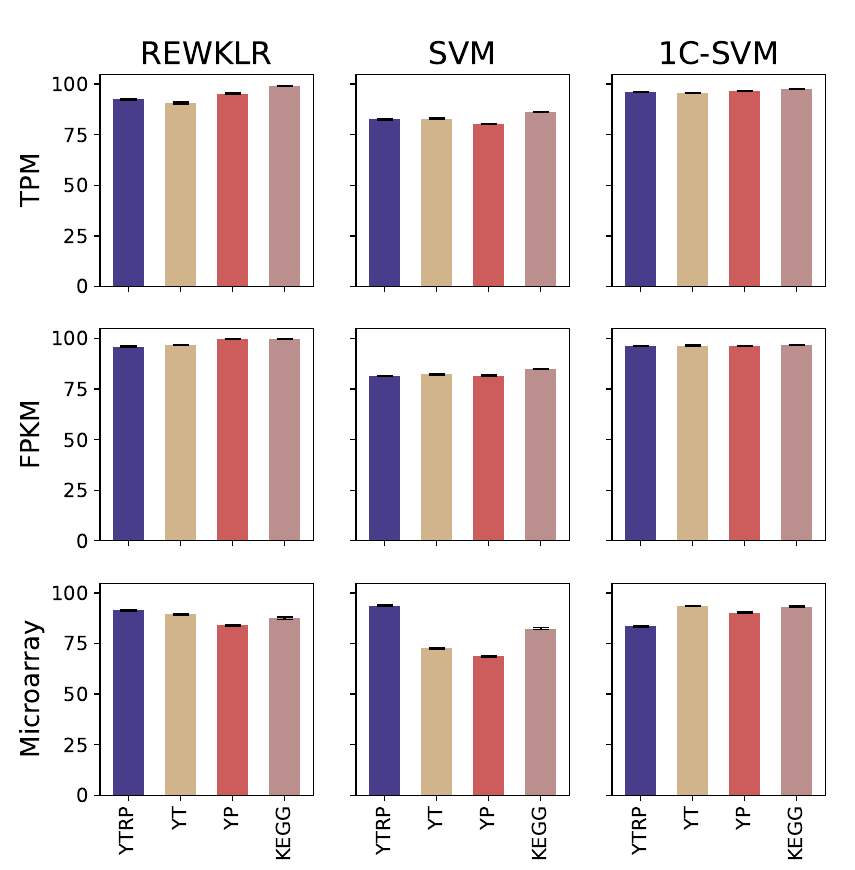
Figure 7. The performance results reported for the combination of all datasets, benchmarks, and classification models in terms of average recall. This resulted in curating twelve different testing datasets used for prediction. Each dataset (RNA-seq TPM normalized, RNA-seq FPKM normalized, and microarray) was validated using four different benchmarks (YTRP, YT, YP, and KEGG). The curated datasets were classified and evaluated using classifiers (REWKLR, SVM, and one-class SVM).